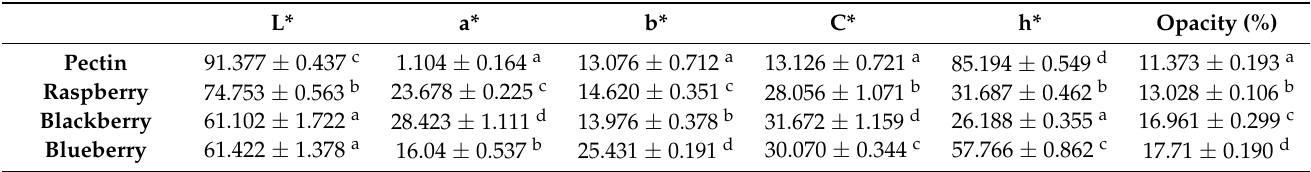
Table 3. Color and opacity of the developed